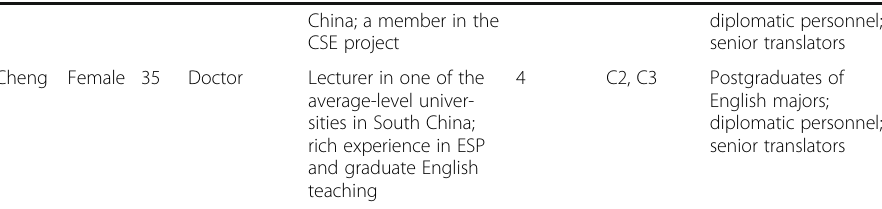
Table 1 Background information of the working group (Continued)